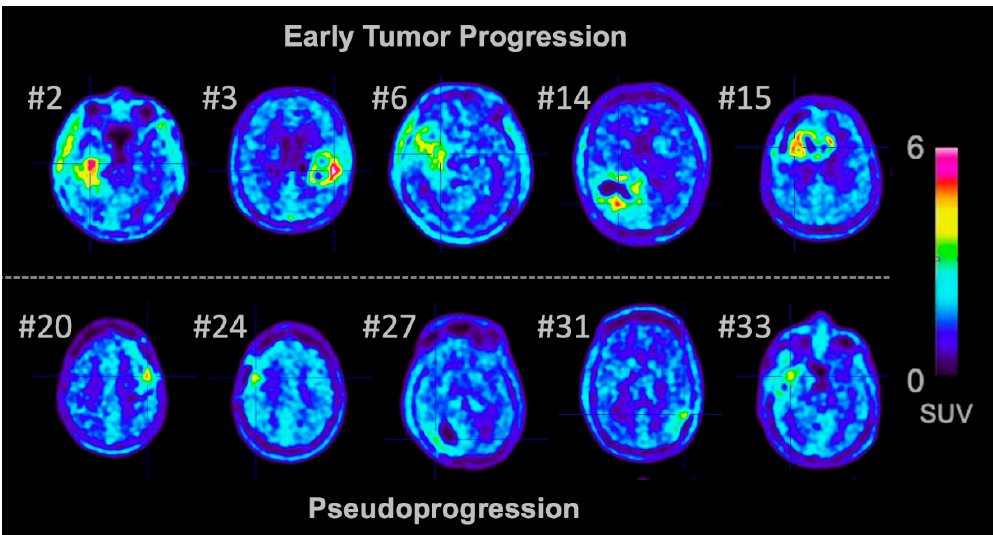
Figure 2. Representative O-(2-[ 18 F]fluoroethyl)-L-tyrosine (FET) positron emission tomography (PET) images of glioblastoma patients with early tumor progression (top row) and pseudoprogression (bottom row). Patients with pseudoprogression showed a slightly lower and more homogenous FET uptake, whereas patients with early tumor progression showed a more heterogenous FET uptake. This visual impression was also reflected by the identified radiomics parameters.